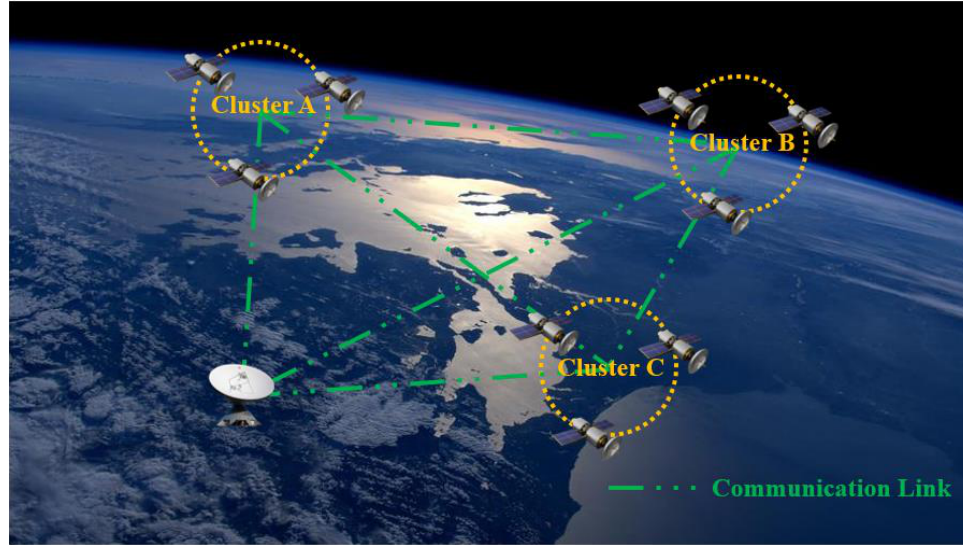
Figure 1. The basic decentralized communication architecture of the satellite cluster.